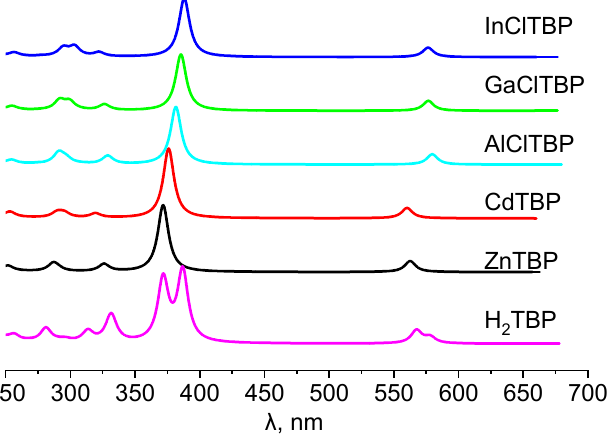
Figure 4. Calculated TDDFT electronic absorption spectra for H 2 TBP , MTBP and MClTBP com- plexes.